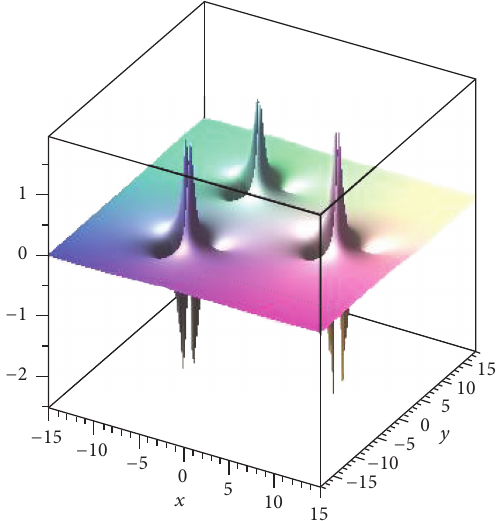
Figure 3: Homothetic solution at 𝑡 = −200 . The equilateral triangle is easily